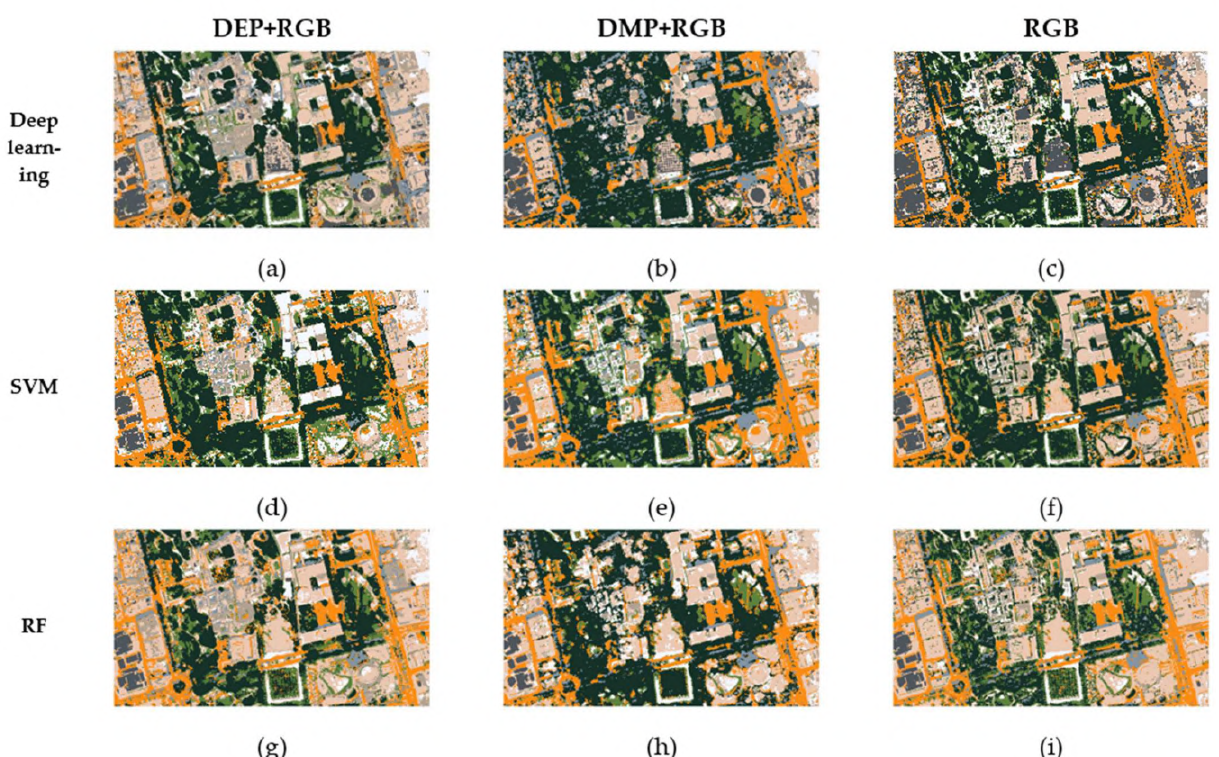
Figure 8. The classification results of ( a ) Deep learning with DEP + RGB ( b ) Deep learning with DMP + RGB ( c ) Deep learning with RGB ( d ) SVM with DEP + RGB ( e ) SVM with DMP + RGB ( f ) SVM with RGB ( g ) RF with DEP + RGB ( h ) RF with DMP + RGB ( i ) RF with RGB for World-View 2